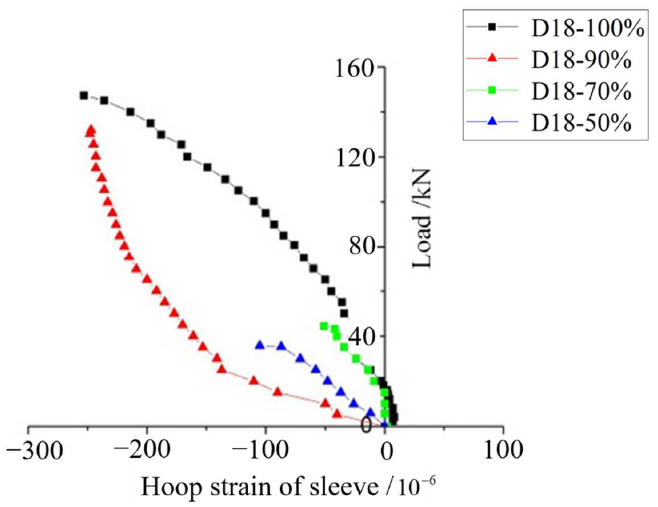
Figure 15. Load-hoop strain curves of the sleeve for the D 18 connector with different compactness.